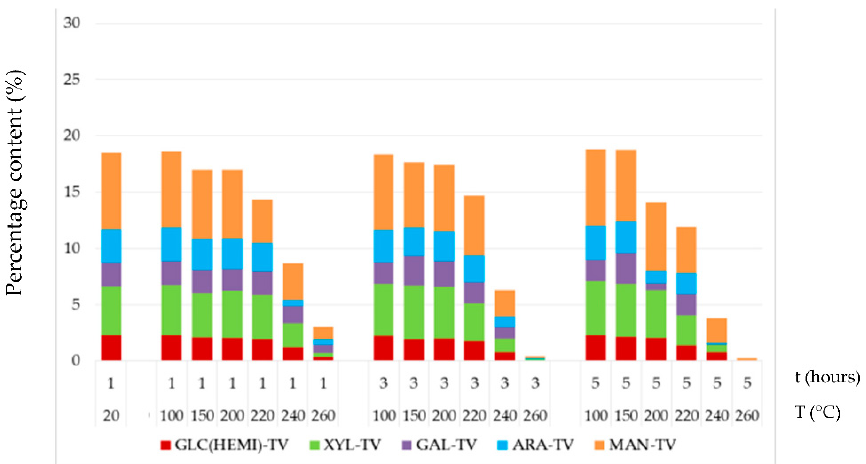
Figure 8. Percentage contents of the individual hemicelluloses in thermally–fungally attacked spruce wood by S. lacrymans . Note: ARA = arabinose, GAL = galactose, MAN = mannose, XYL = xylose and GLC = glucose.